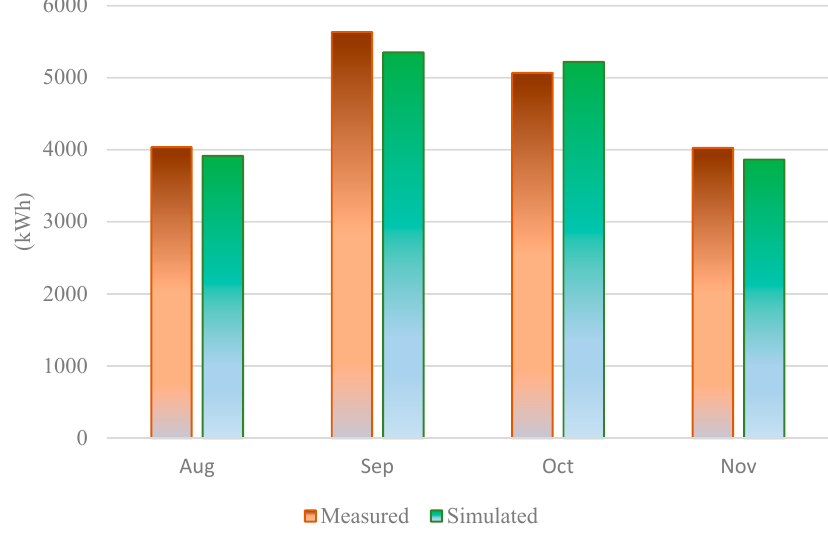
Figure 13. Comparison between energy supplied by the PV system versus the simulated PV system.